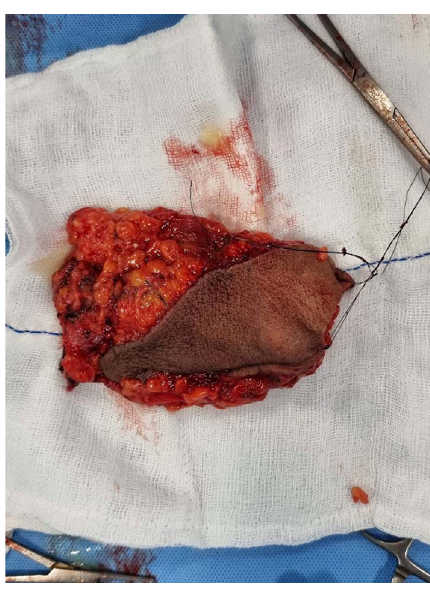
Figure 5. Sac with its communication to AC joint shown. Figure 7. Sac excised in toto with super fi cial skin.